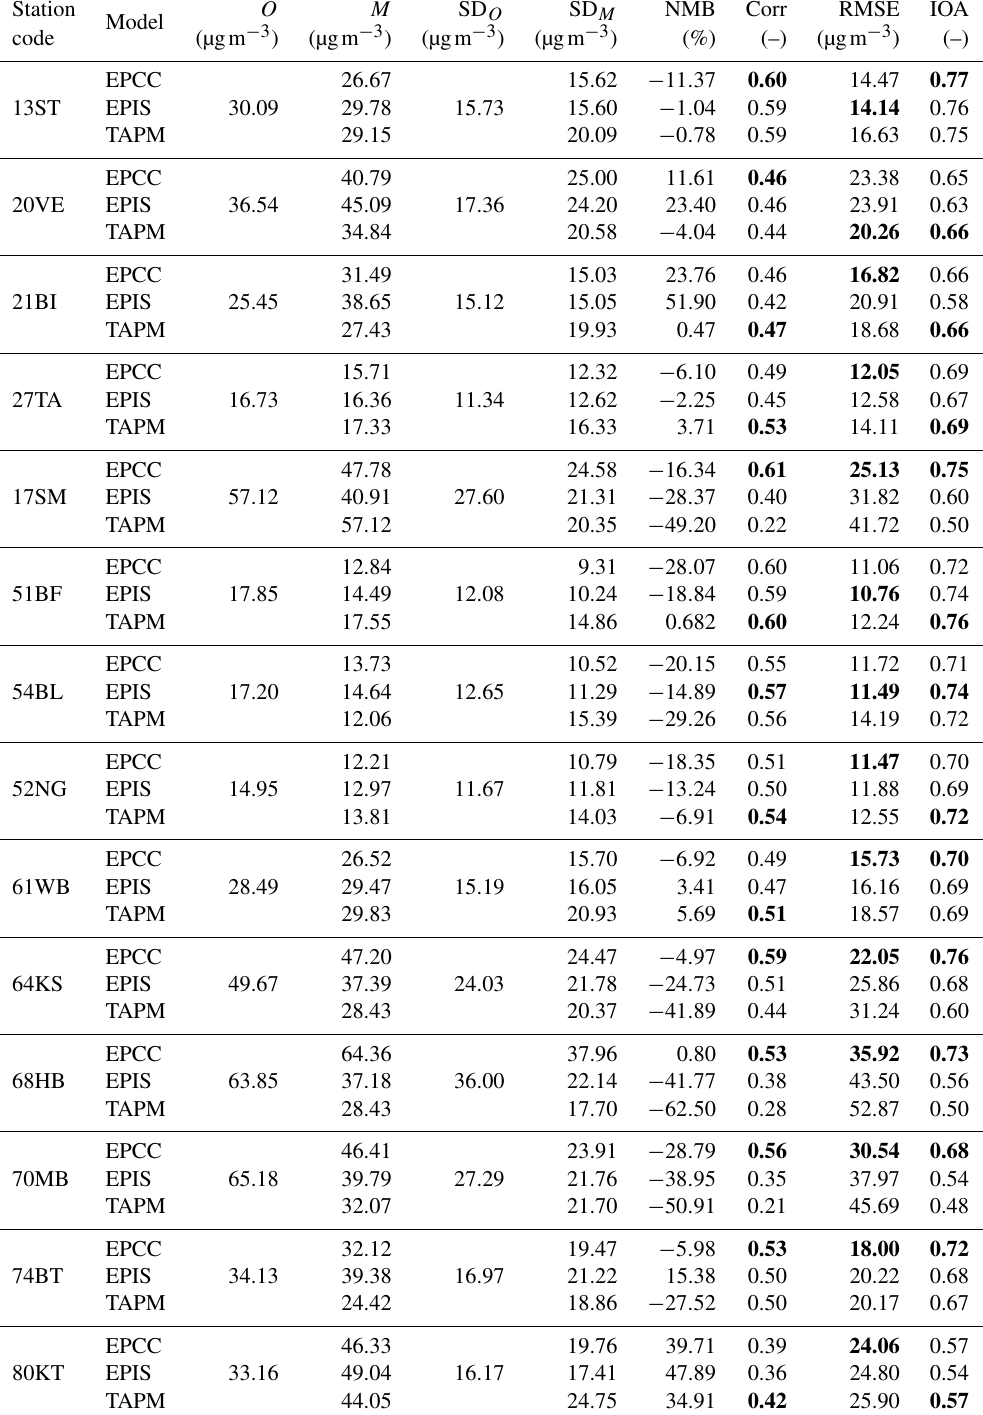
Table 7. Model performance statistics of EPISODE–CityChem (EPCC), standard EPISODE (EPIS) and TAPM for the temporal variation of NO 2 based on hourly concentration at all stations with sufficient data available in 2012. Bold numbers represent model results with better performance for Corr, RMSE and IOA per